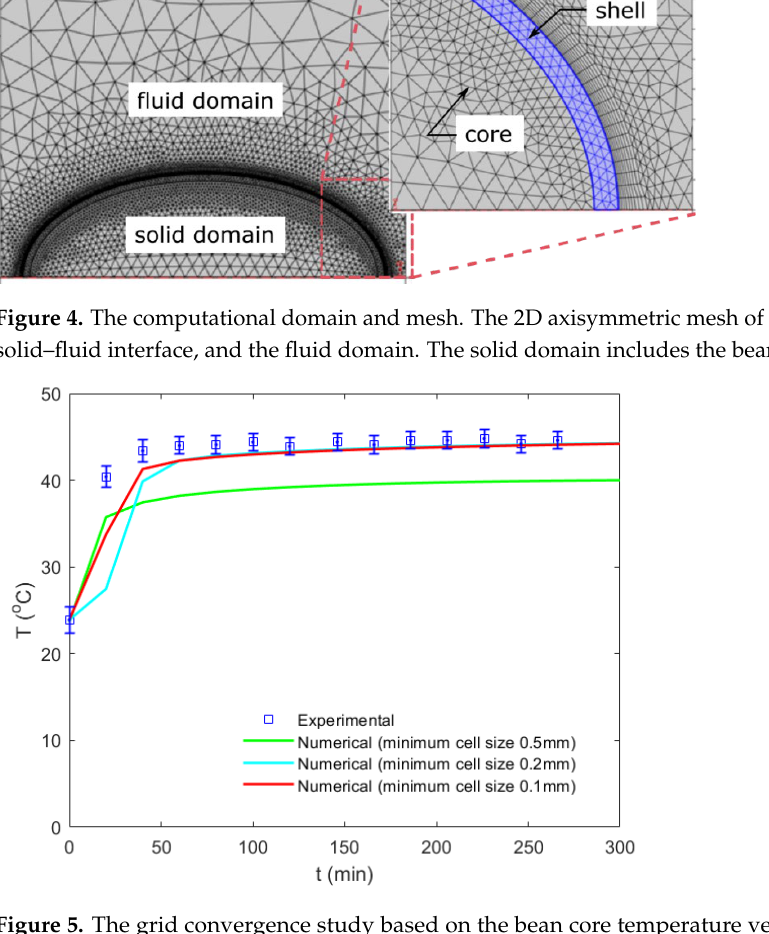
Figure 5. The grid convergence study based on the bean core temperature versus the drying time under a constant temperature drying condition of 50 °C.